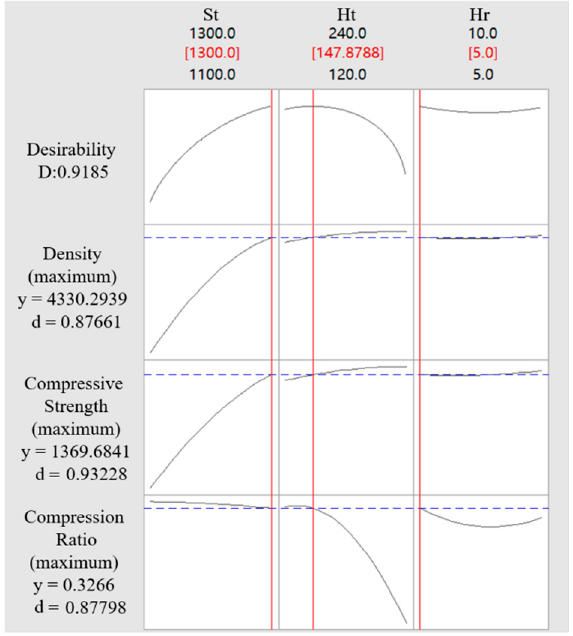
Figure 12. The optimal response result graph of this experiment. Table 6. Analysis of the verification experiments.